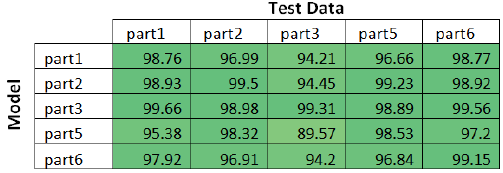
Figure 4. Final accuracy heat map